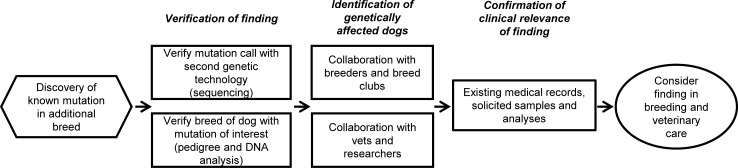
A proposed standard operating procedure for handling mutation discoveries in additional breeds.